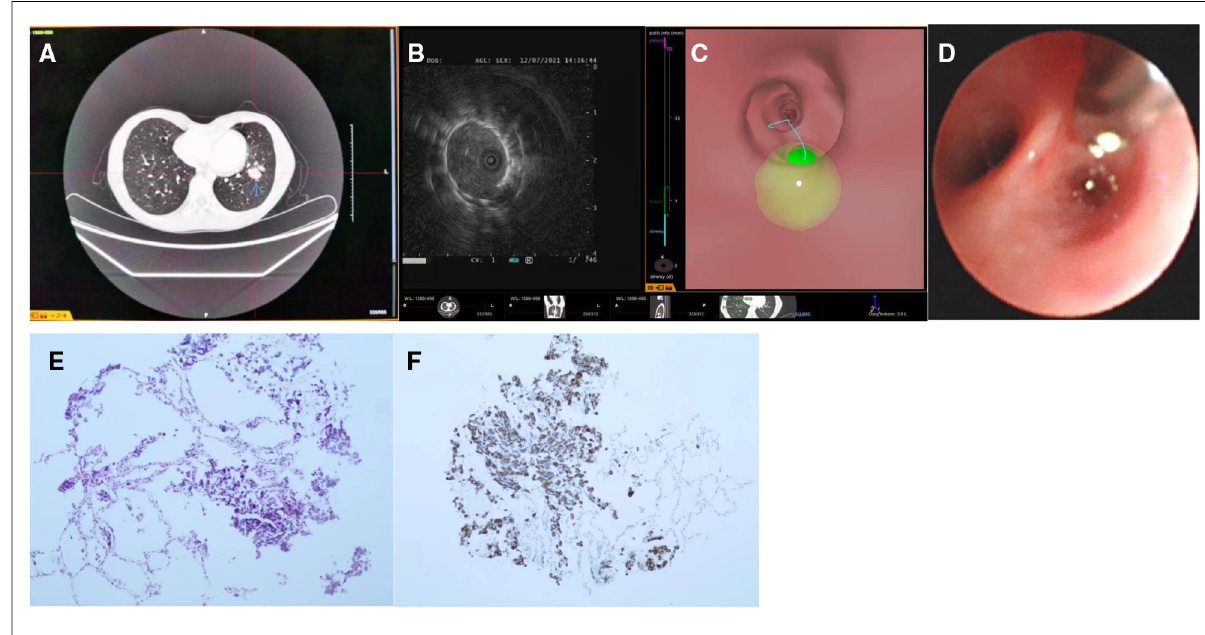
FIGURE 1 The operation process of archimedes virtual bronchoscopic navigation (VBN)-guided lung biopsy. ( A ) CT data requirements; ( B ) Lesions selected and marked (green region); ( C ) Selected navigation path; ( D ) Real-time guidance during navigation; ( E ) Reach the targeted location; ( F ) Radial endobronchial ultrasound image of the